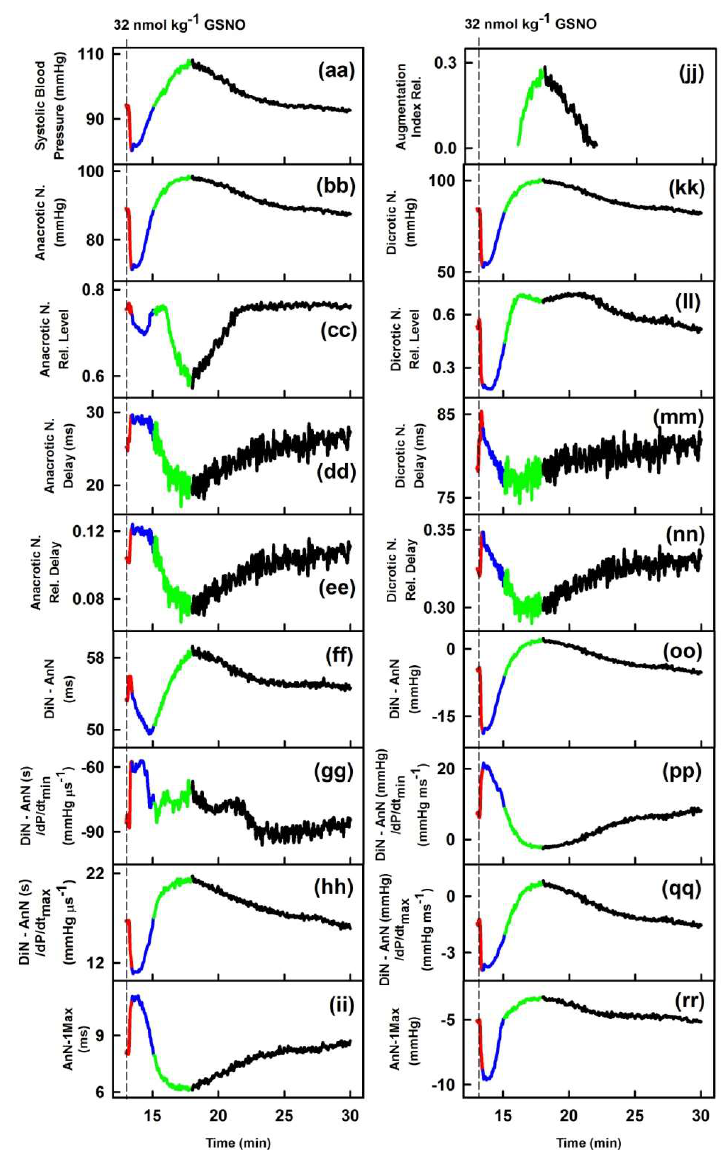
Figure 2. Time-dependent changes of hemodynamic parameters (HPs) of anesthetized rat after i . v . bolus administration of 32 nmol·kg –1 S-nitrosoglutathione (GSNO) (marked by dash lines). The red line starts 3 s before GSNO administration. Time period corresponding to the decrease of systolic BP (red), increase of systolic BP to the control value (blue), further increase of systolic BP to maximum (green), and decrease of systolic BP to the control value (black). Units in plots (gg), (hh), (pp), and (qq) are informative only.